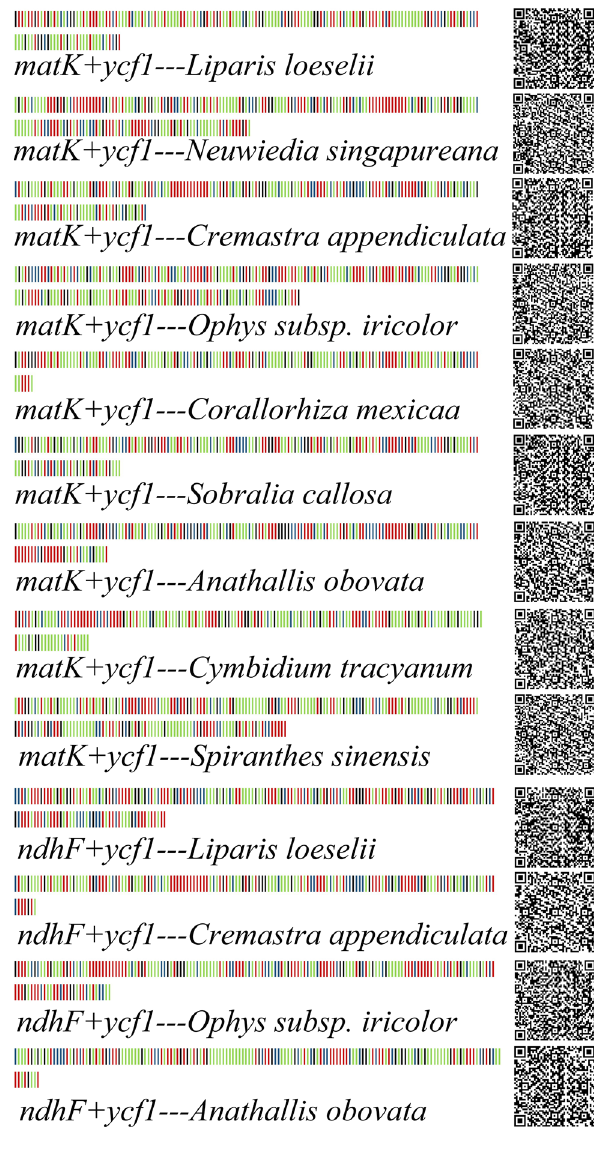
Figure 11. DNA barcodes and two-dimensional DNA barcodes of Orchidaceae species based on matK + ycf1 and ndhF + ycf1 genes. Base A in green, base T in red, base C in blue, and base G in